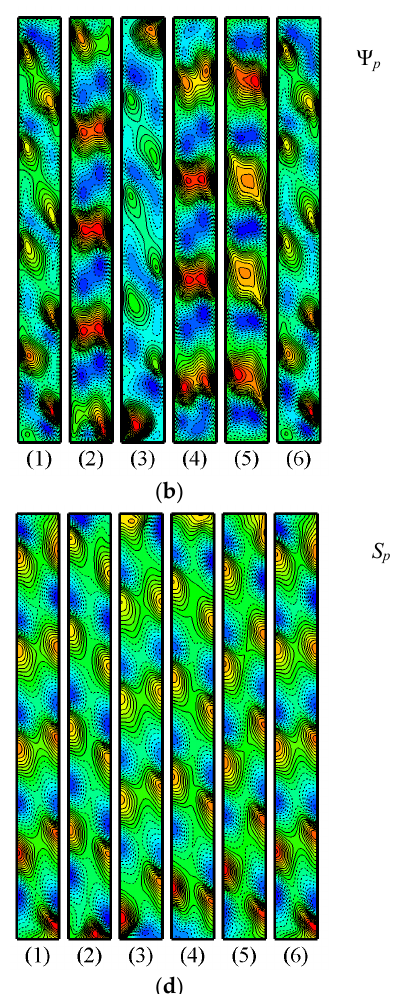
Ψ , as predicted by the numerical solution, and ( b – d ) snapshots of Figure 16. ( a ) Time evolution of the stream function, 0 Figure 16. ( a ) Time evolution of the stream function, Ψ 0 , as predicted by the numerical solution, and ( b – d ) snapshots of the the perturbations of the stream function, Ψ , temperature, p perturbations of the stream function, Ψ p , temperature, T p and concentration, S p , for A = 10, R T = 910, Da e = 10 − 4 , Le = 2, D u = S r = 0.1, ξ = 0, ε = 1 and τ = 0.1775.